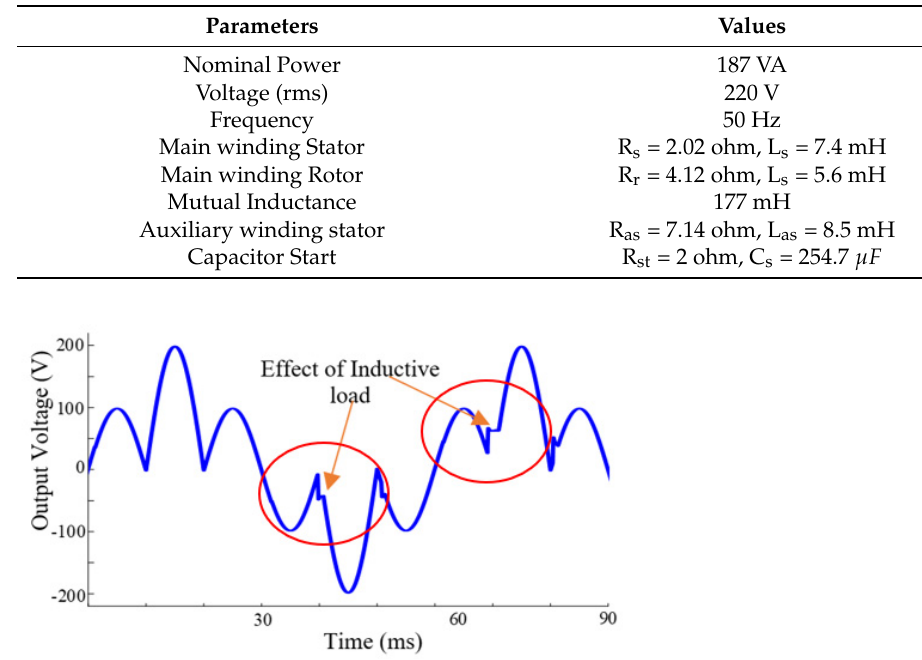
Figure 8. Output voltage of one − third frequency conversion of input frequency for motor load.